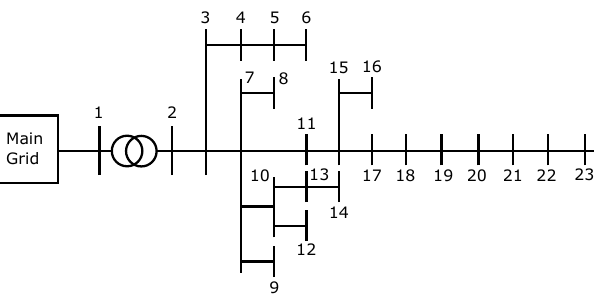
Figure 4. LV Distribution